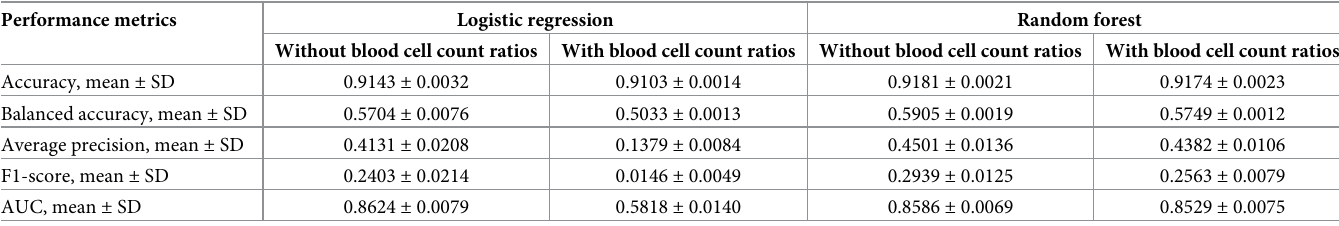
All models included the features: age group, sex, and laboratory blood test results of ten CBC parameters, with five-fold cross-validation and without any model optimization focusing on the prediction of secondary headaches.